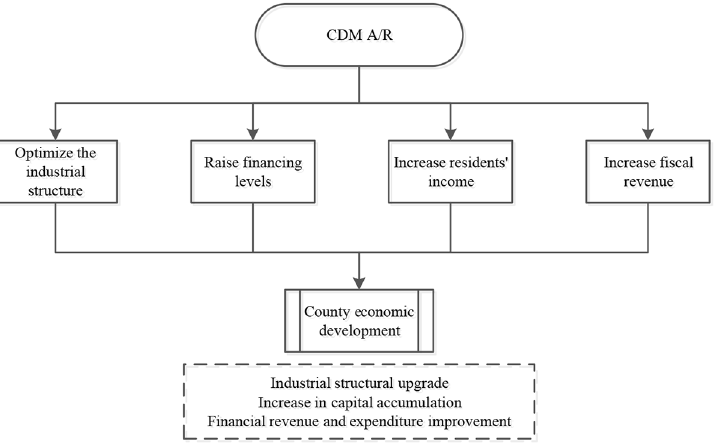
Figure 1. Theoretic